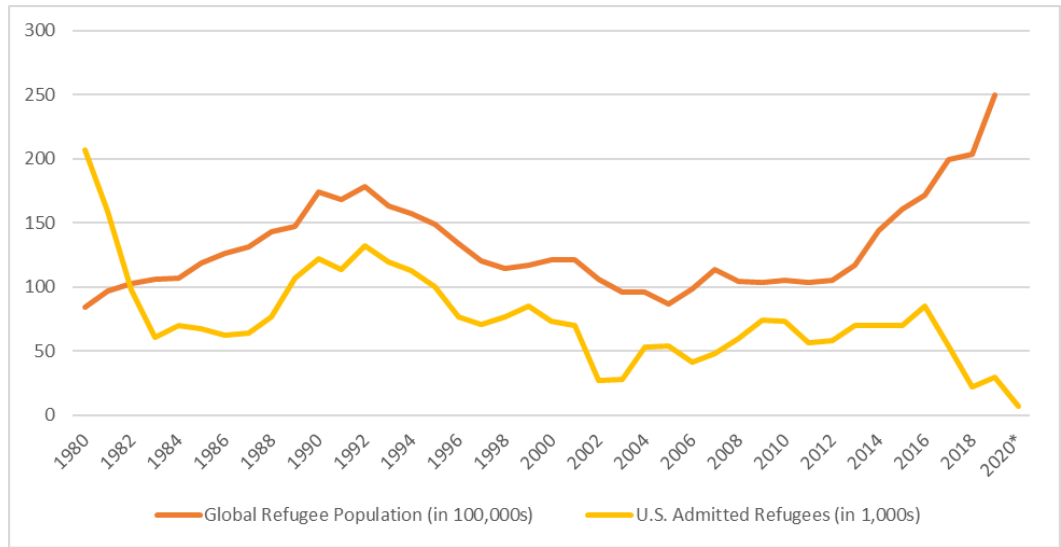
Figure 3. Number of refugees admitted to the United States (in 1000s) vs. global population of refugees (in 100,000s), 1980–2020. * Figures for FY 2020 represent partial-year data; 1 October 2019